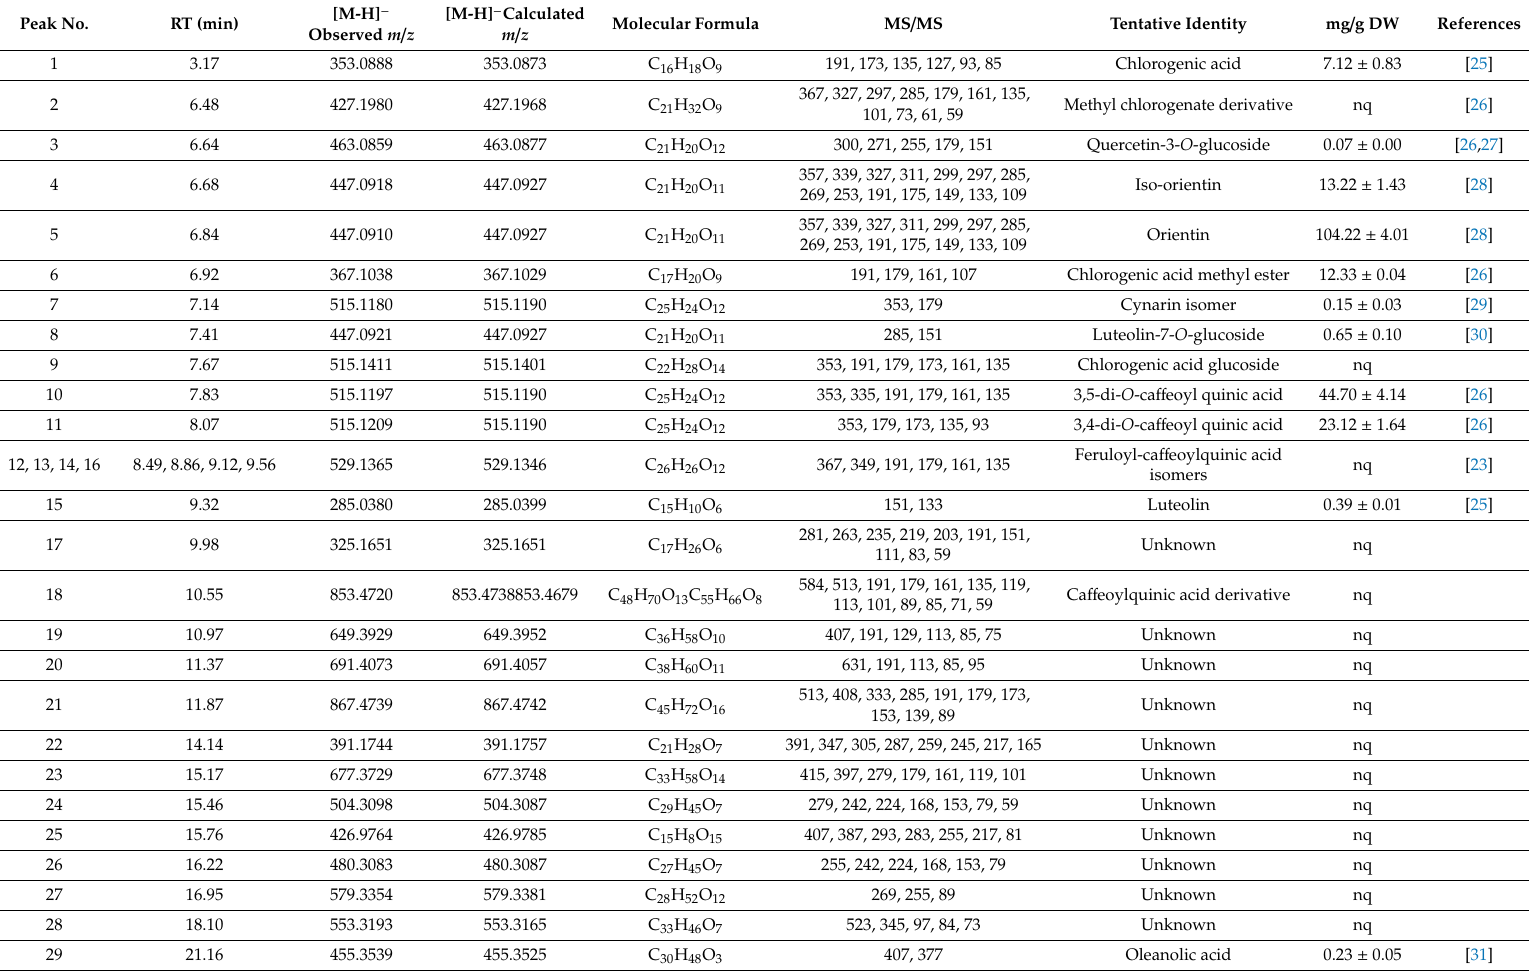
Table 5. Liquid chromatography-tandem mass spectrometry (LC–MS / MS) of ethyl acetate fraction of Azorella glabra . Peak